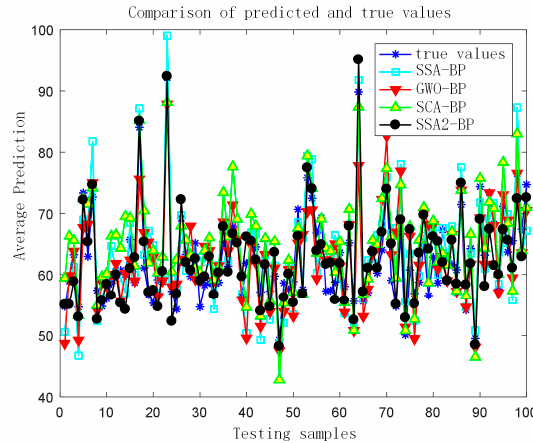
Figure 9. Comparison of the predicted value and the true values.